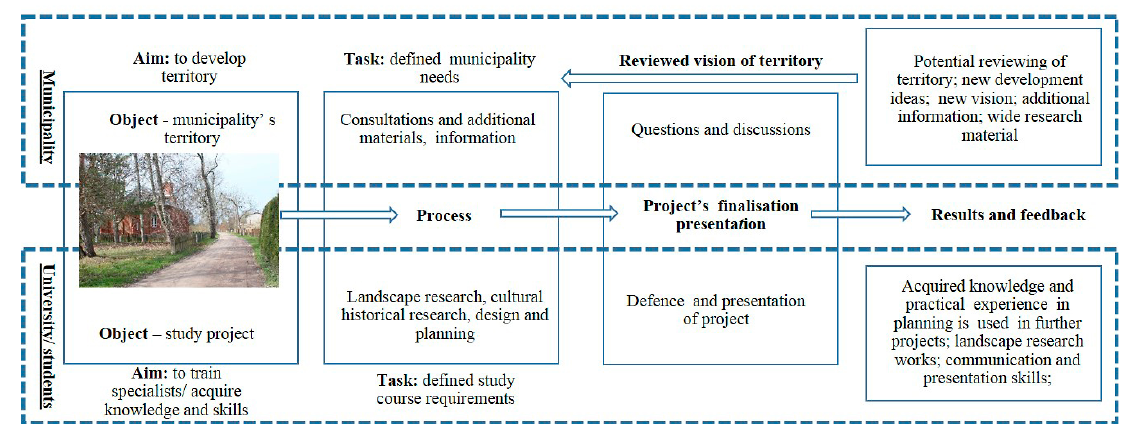
Fig. 2. Trilateral cooperation trough service